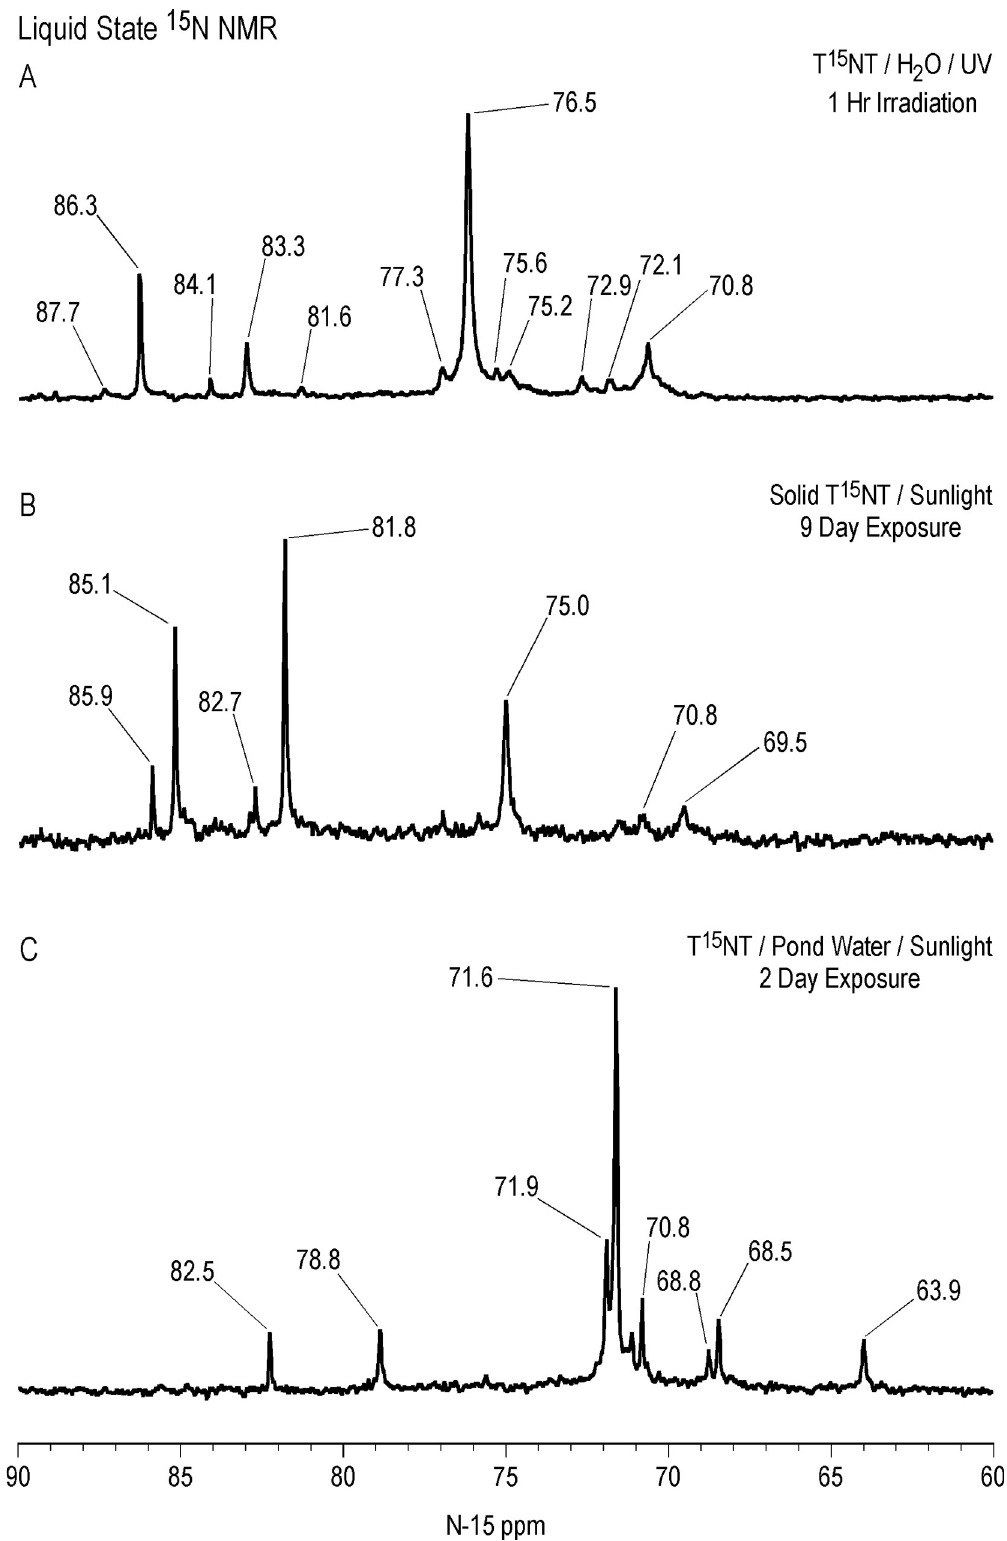
Fig 14. Liquid state ACOUSTIC N-15 NMR spectra of aromatic amine region of irradiated T 15 NT. Line broadening = 1 Hz. Spectra phased 180˚. A. 1 hour lamp irradiation in deionized water. B. 9 day sunlight irradiation in the solid state. C. 2 day sunlight irradiation in pond